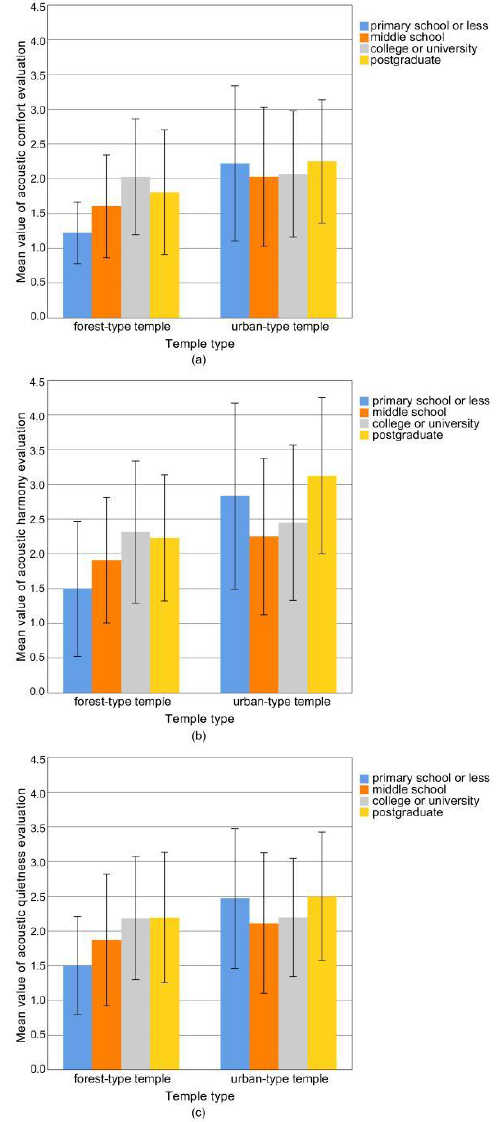
Figure 7. The evaluation value and standard deviation of the acoustic environment by different respondents’ educational level: ( a ) comfort; ( b ) harmony; ( c ) quietness.